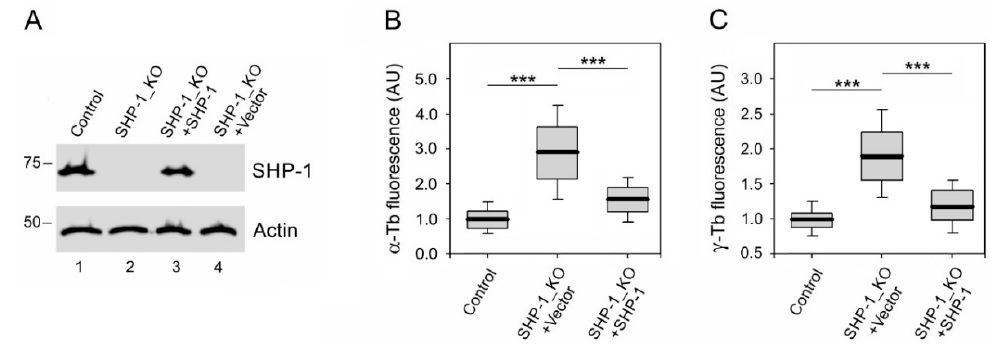
Figure 7. Microtubule regrowth in a phenotypic rescue experiment. ( A ) An immunoblot analysis of SHP-1 in whole-cell lysates from BMMCs (Control), SHP-1_KO cells, SHP-1_KO cells